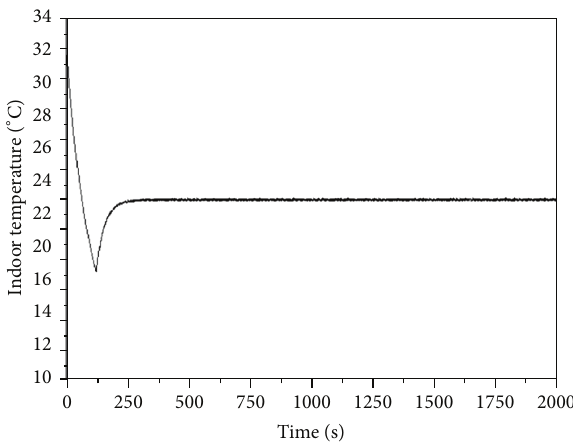
Figure 11: Zone temperature versus time for PID controller.